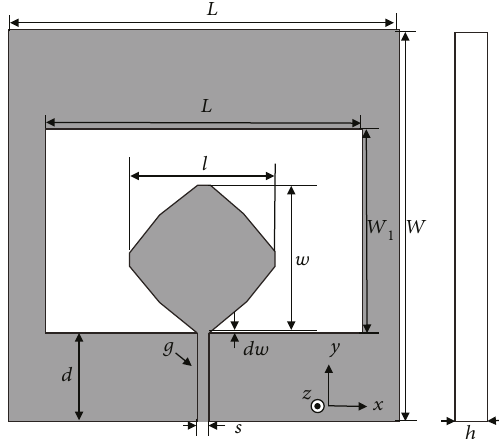
Figure 10: A shape-blending algorithm was used to design an antenna with a wide slot